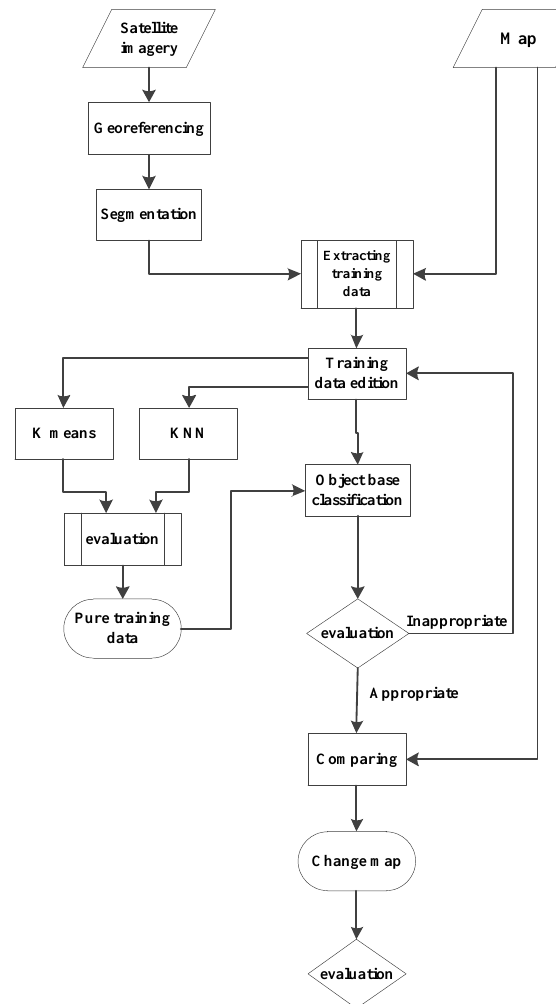
Figure 1. The study procedure.